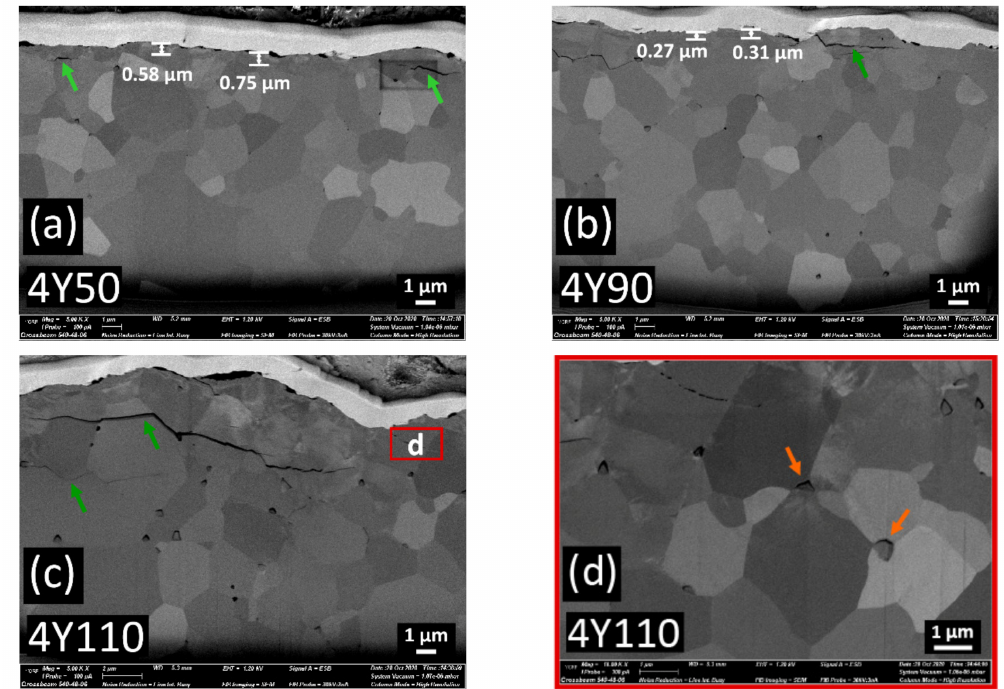
Figure 8. FIB cross-sections of ( a ) 4Y50, ( b ) 4Y90, ( c ) 4Y110; the thin box indicates the location of detail ( d ), ( d ) detail of the deformed zone of 4Y110. Microcracks (shown in green arrows) are present and are limited to the first 1 µ m in 4Y50, while microcracks grow in the horizontal direction and are connected to the surface in 4Y90. 4Y110 shows the homogenous deformed layer instead of isolated transformed grains beneath the surface and lateral cracks are located up to 4.5 µ m under the surface. The transverse extension of cracks could generate material removal (brittle fracture). In detail ( d ), the grains boundaries are destroyed and plastic deformations are detected. Alumina particle debris (shown in orange arrows) was deposited beneath the